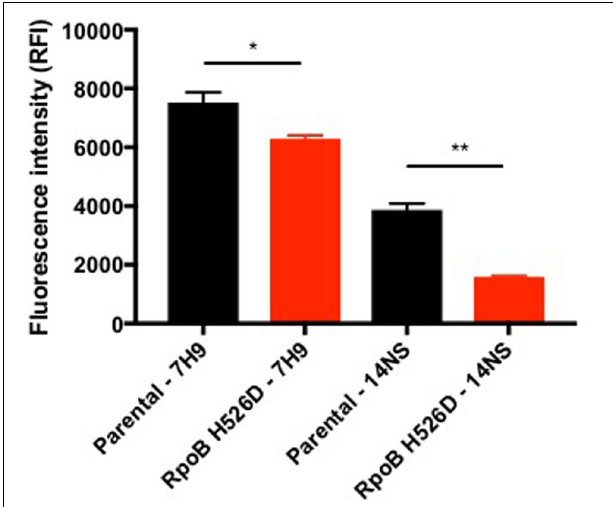
FIGURE 4 | RpoB mutation H526D alters bacterial cellular metabolic activity. The RpoB H526D mutant and parental strains were grown to mid-log-phase in nutrient-rich broth (7H9) or were starved of nutrients for 14 days (14NS) prior to incubation with AlamarBlue for 18 h. The fluorescence signal was normalized based on bacterial density. RFI, relative fluorescence intensity. ∗ p < 0.05, ∗∗ p < 0.01.